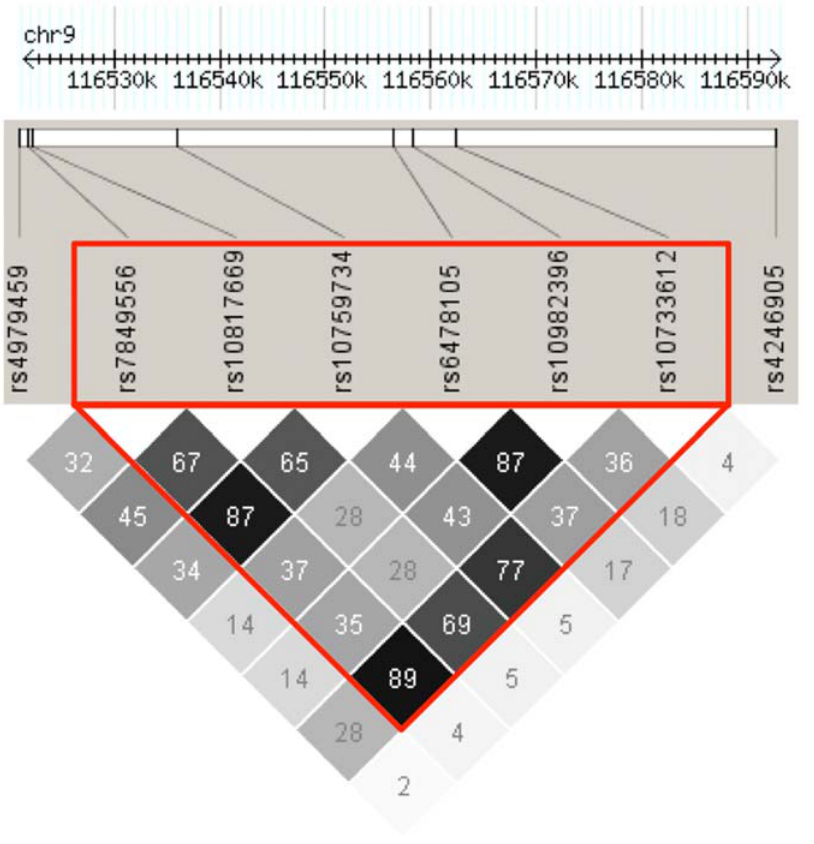
Figure 4. Linkage disequilibrium (LD) plot for the eight single-nucleotide polymorphisms genotyped in the replication study. LD calculations were based on pairwise r 2 values of our entire case/control dataset. These values are displayed, in percentage, in the grey boxes. The red triangle indicates the LD block, computed by the program HAPLOVIEW, which was further used for haplotypic association with the program PLINK.